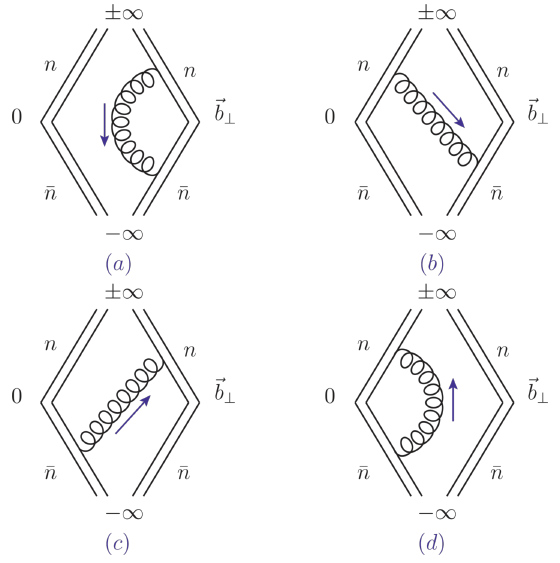
Figure 4 . One-loop diagrams for the soft funtion. Diagram (a)(d) give the virtual diagram, and diagram (b)(c) give the real